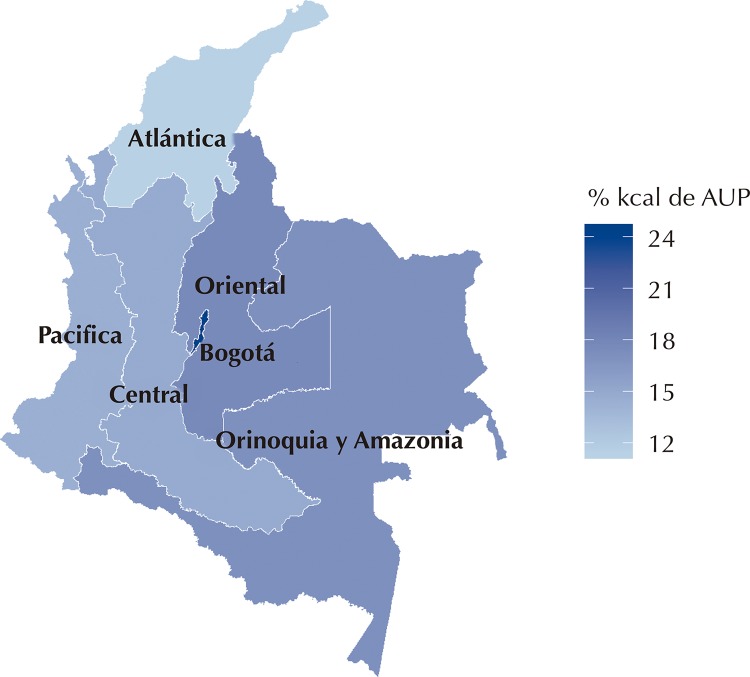
Distribución del consumo de alimentos ultraprocesados (AUP) en las regiones. Colombia, 2005.